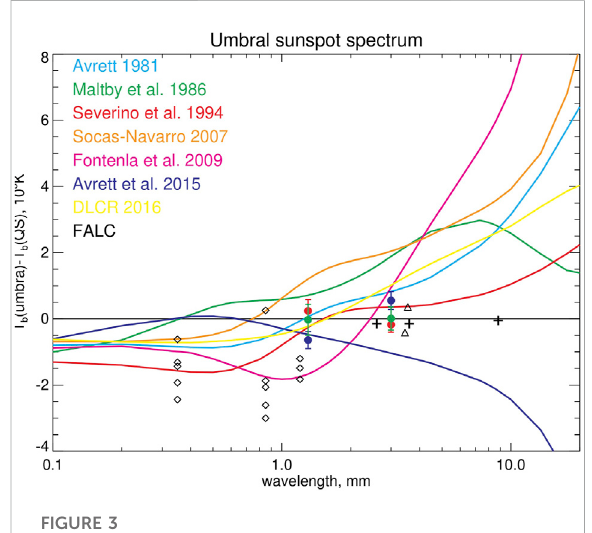
FIGURE 4 Same as in Figure 3 for the penumbral models of Yun et al. (1984) (1984; green), Ding and Fang (1989) (1989; blue), Fontenla et al. (2009) model R (red), and Socas-Navarro (2007) model D (violet). The colored fi lled circles and error bars indicate the observational penumbral mean values with the rms values for the inner penumbra (blue), the outer penumbra (red), and the whole penumbra (green) at 1.3 and 3 mm. The diamonds indicate the brightness measurements at 0.35, 0.85, and 1.2 mm from Lindsey & Kopp (1995). From Loukitcheva et al. (2017). Reproduced by permission of the